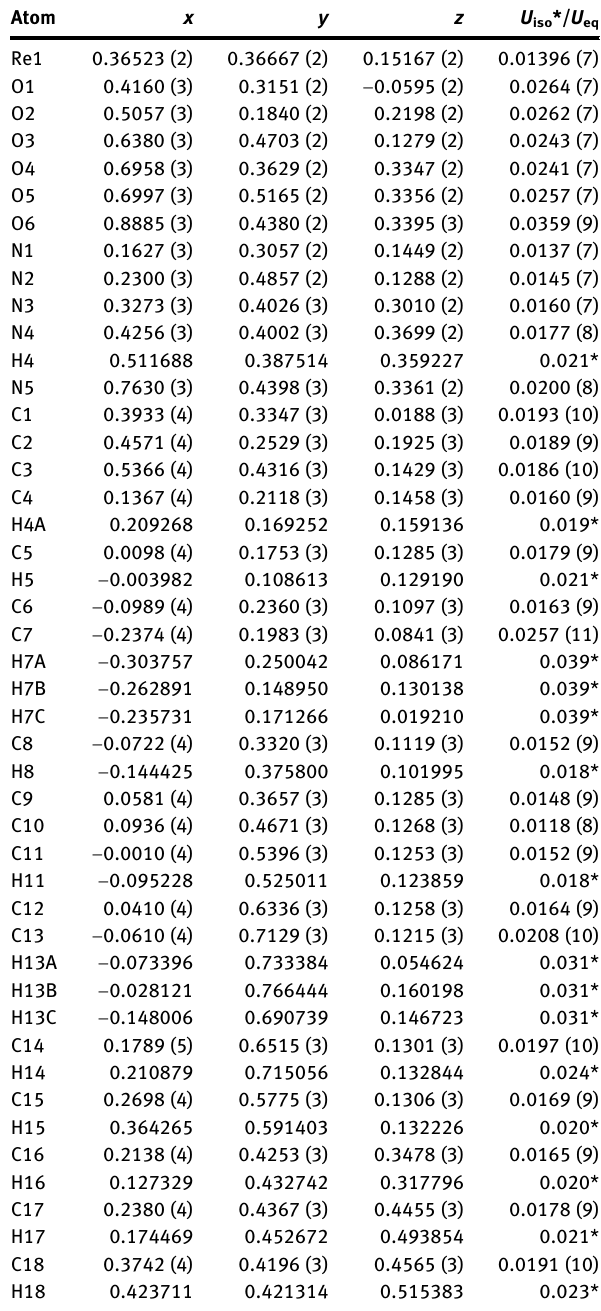
Table  : Fractional atomic coordinates and isotropic or equivalent isotropic displacement parameters (Å 